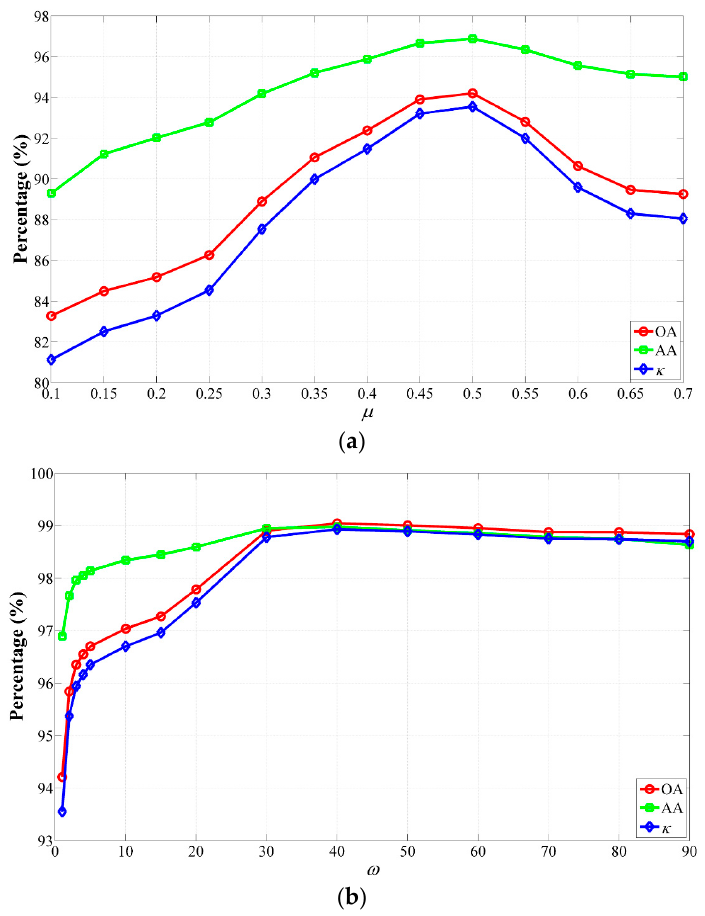
Figure 12. Analysis of the impact of μ and ω on classification accuracies using the CS-GC method for the Salinas data set. ( a ) Evolution of classification accuracies against different values of μ ; ( b ) evaluation of classification accuracies against different values of ω .